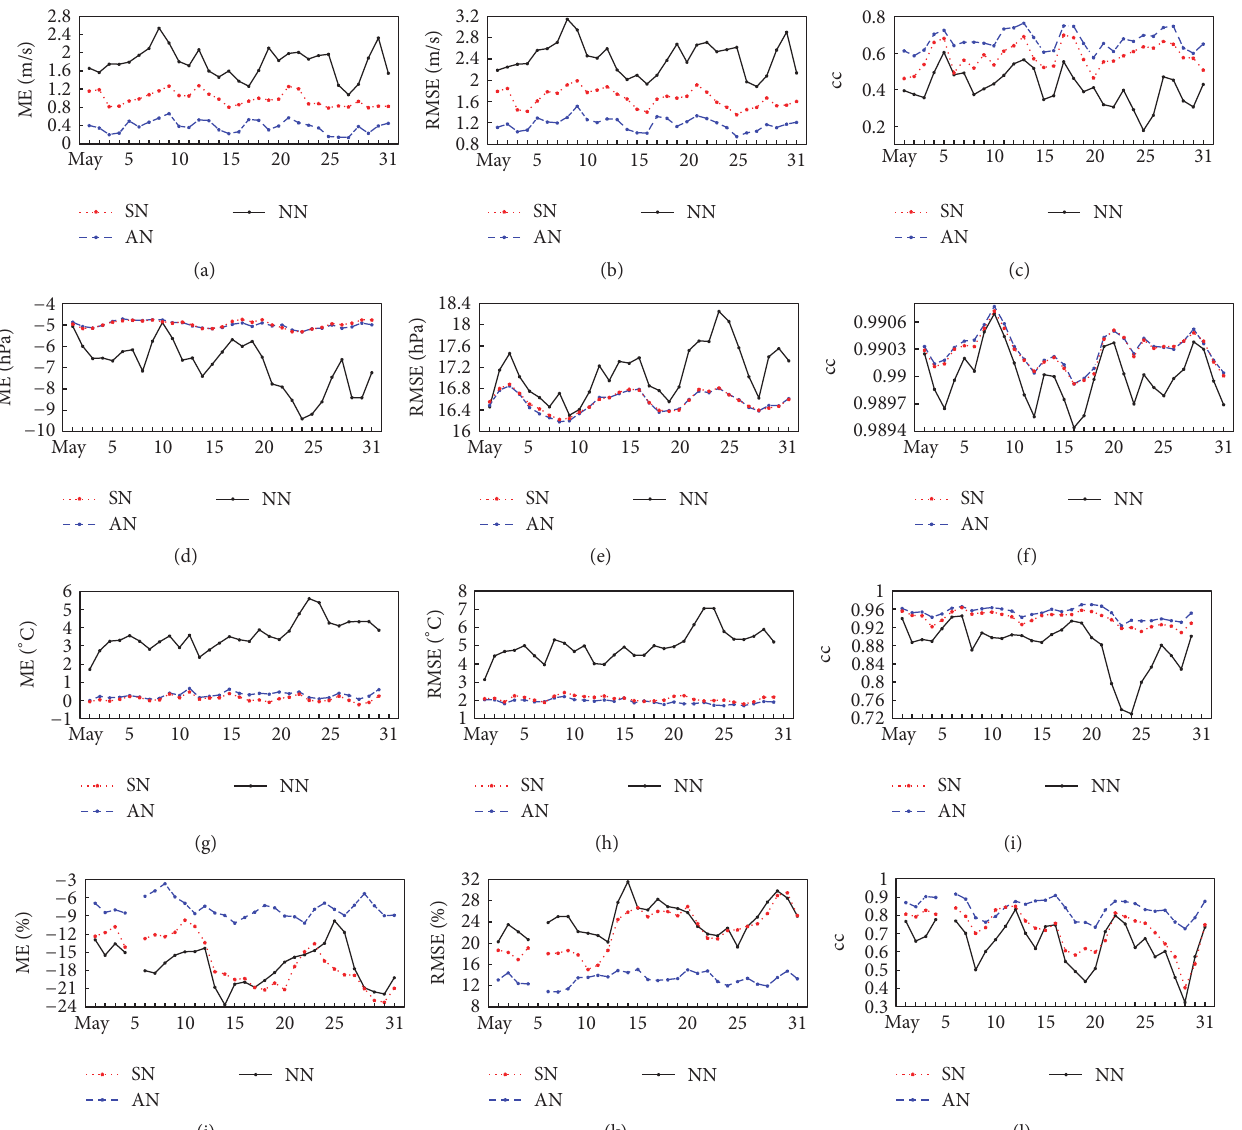
Figure 6: Time series plots of related statistical verification techniques for daily averaged conventional meteorological elements near the surface for May,